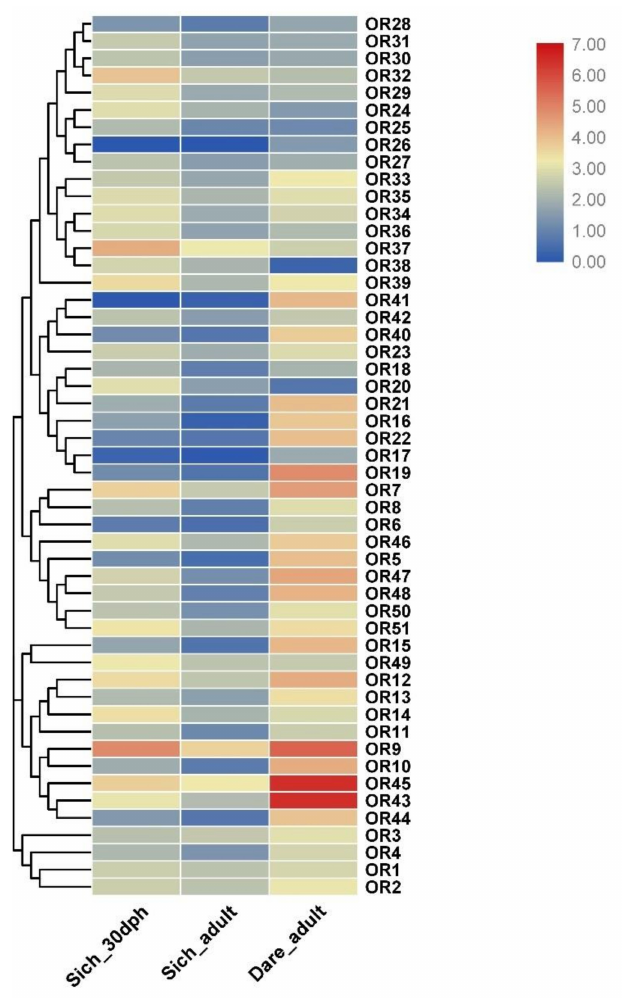
Figure 5. Expression profiles of OR genes in the olfactory epithelium. Heat map showing the expression levels of OR genes in two stages of 30 dph and adult Chinese perch, and the adult zebrafish. As shown in the bar to the right of Figure 5, gene transcript abundance is represented by different colors in the map. The FPKM (fragments per kilobase of exon model per million mapped fragments) values of the OR genes are presented in Supplementary data